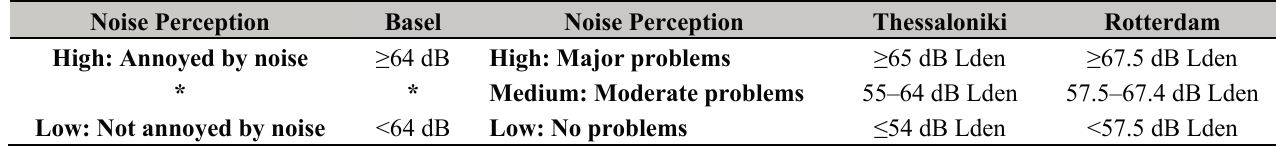
Table 4. Noise perception category ranges for the city noise exposure